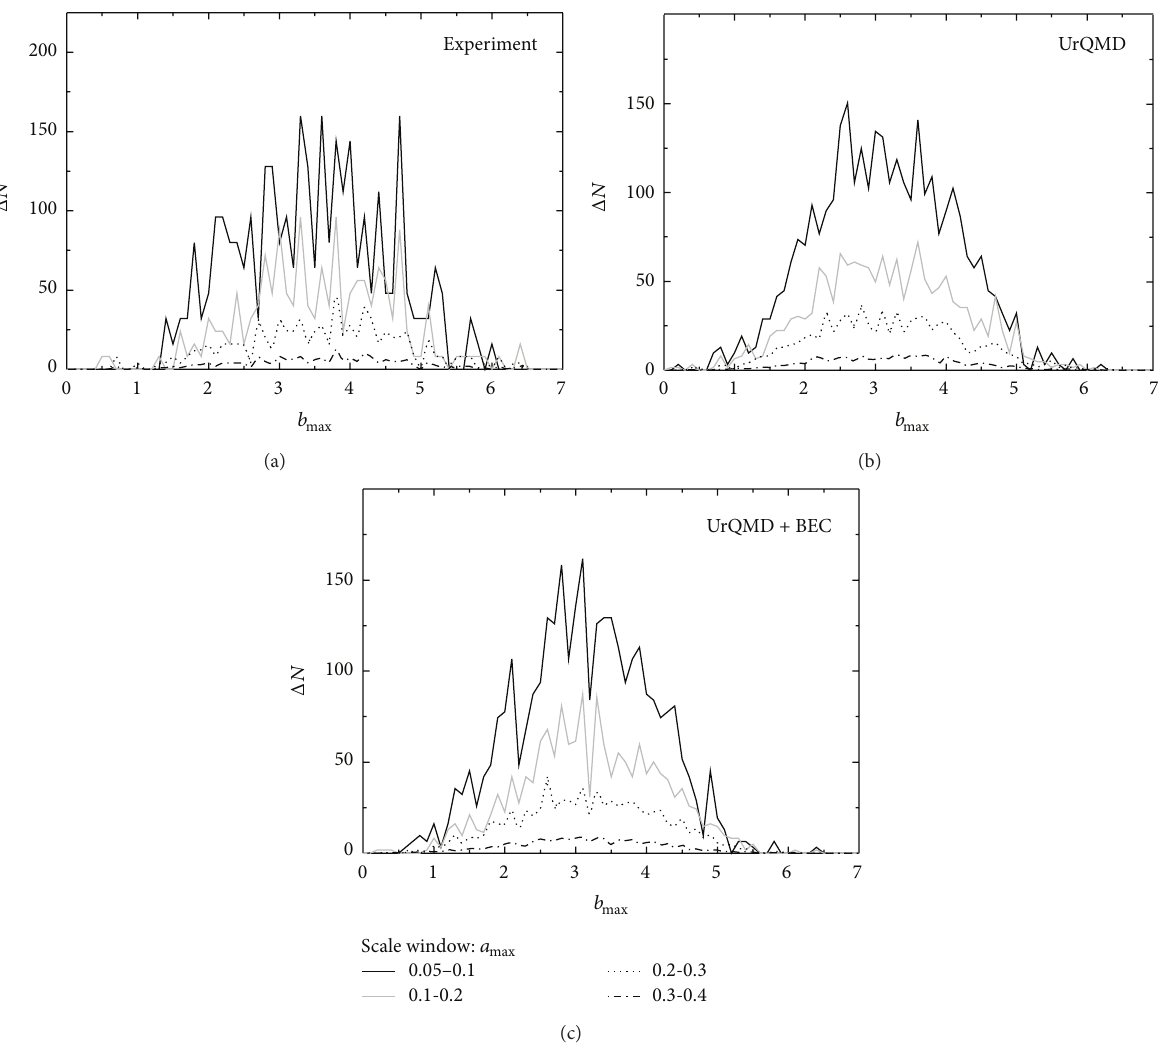
Figure 11: The same as Figure 10 but for 32 S-Ag/Br interaction at